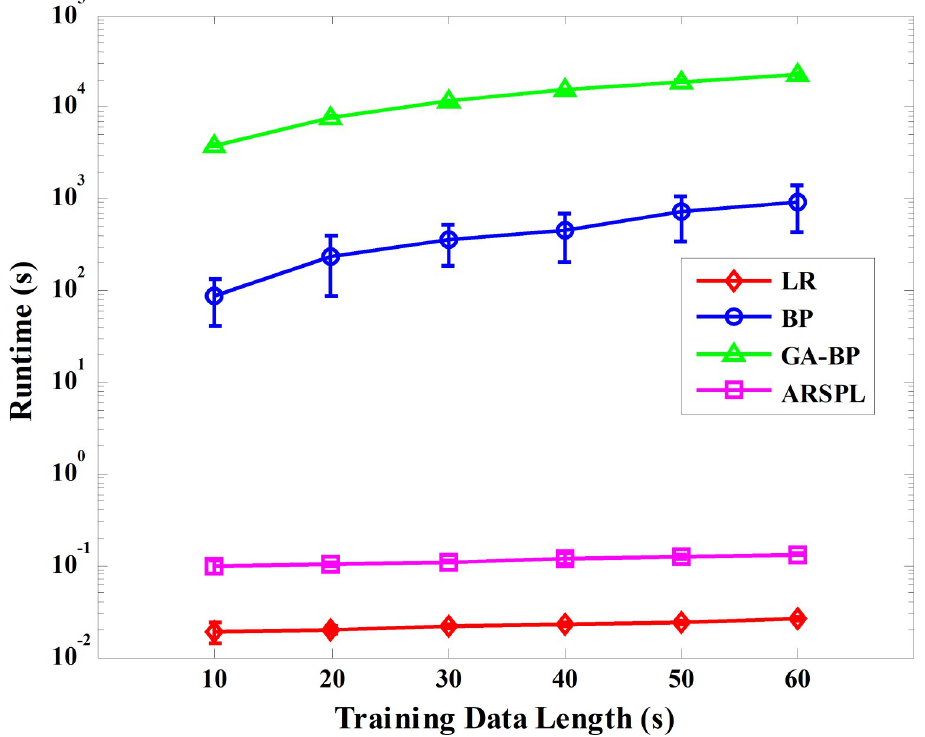
Fig 7. Algorithm runtime